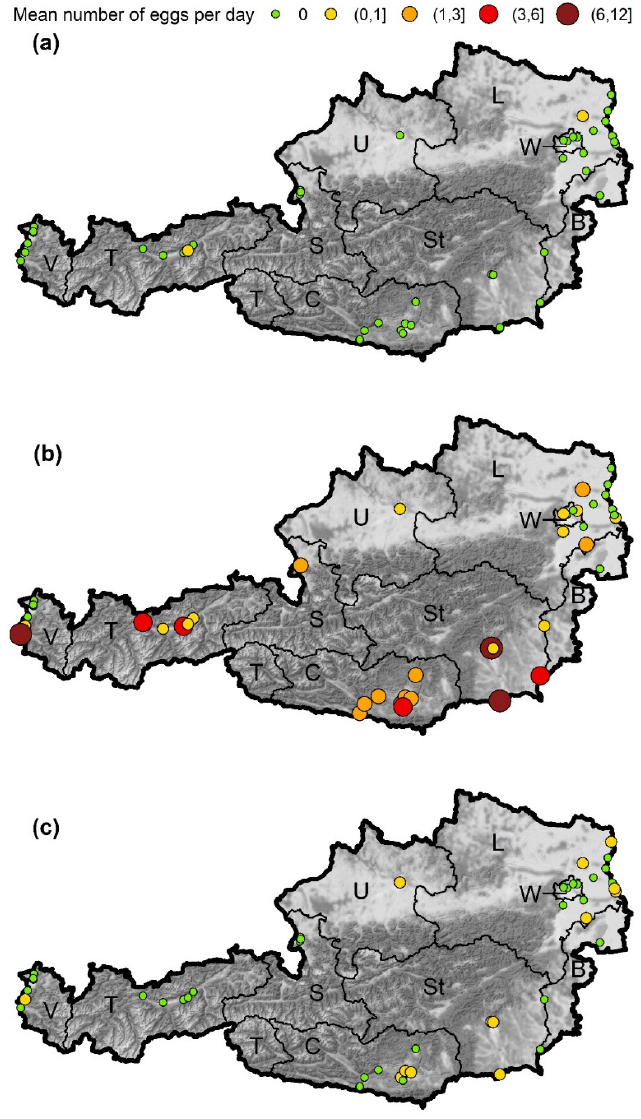
Figure 2. Mean number of eggs per day and site detected in the ovitraps. The number of eggs was categorized, the start and end values given in brackets for values > 0. Round brackets indicate endpoints which are excluded, endpoints with square brackets are included in a category. ( a ) Ae. albopictus , ( b ) Ae. japonicus , ( c ) Ae. geniculatus . Austrian provinces: W—Vienna, L—Lower Austria, Vorarlberg. Map tiles by Stamen Design, under CC BY 3.0. Data by OpenStreetMap, under ODbL. Data source borders: NUTS units, Statistik Austria—data.statistik.gv.at, accessed on 18 January